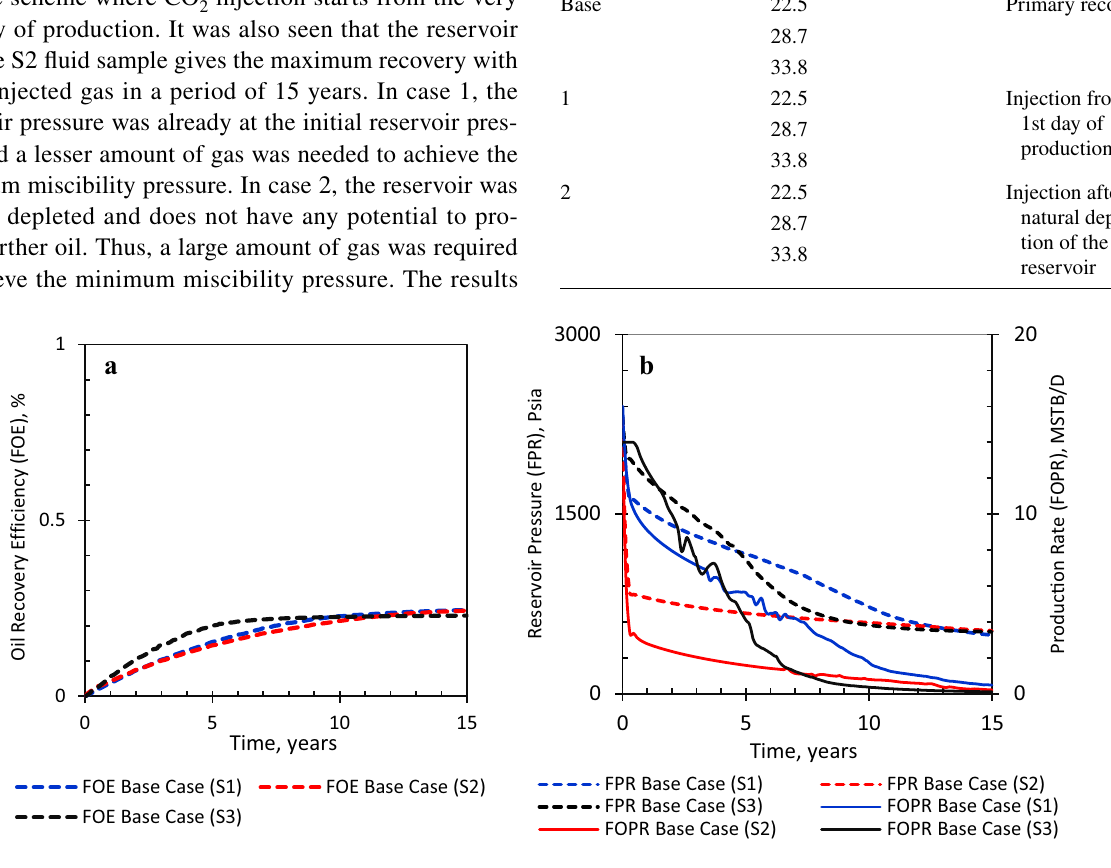
Fig. 9 a Oil recovery efficiency, b Production rate and reservoir pressure against time in the base case